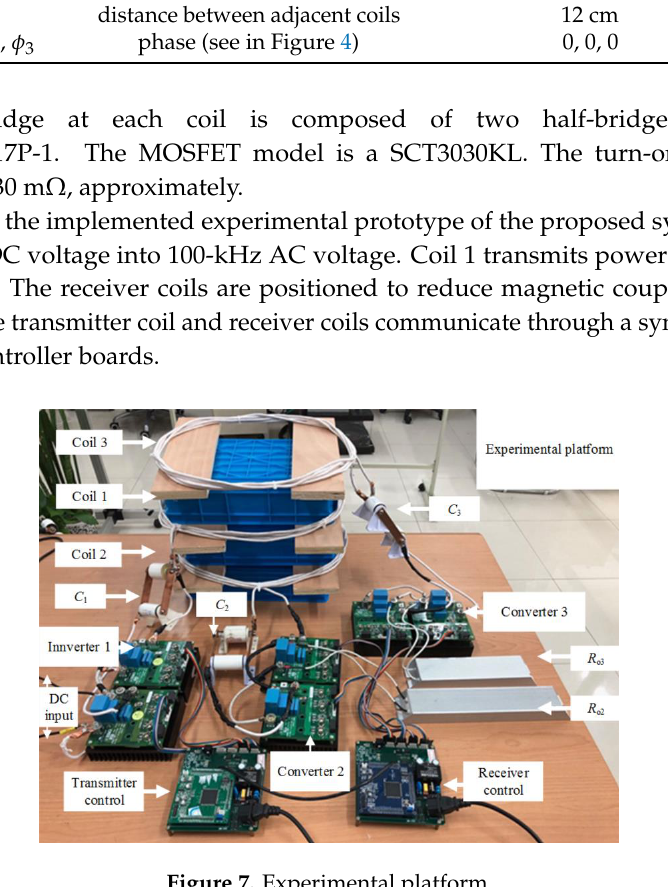
( b ) Figure 8. Experimental waveform: ( a ) transmitter coil; ( b ) receiver coils.